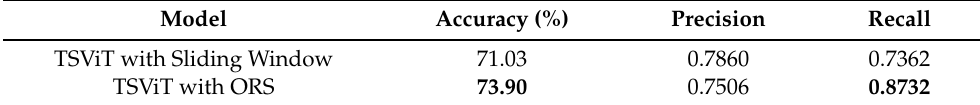
Table 4. Performance comparison between proposed ORS and the sliding window-based sampling method.